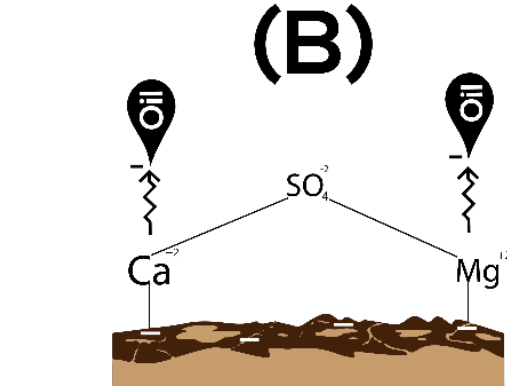
Table 1. Studies with focus on interfacial-interaction as a potential recovery mechanism.